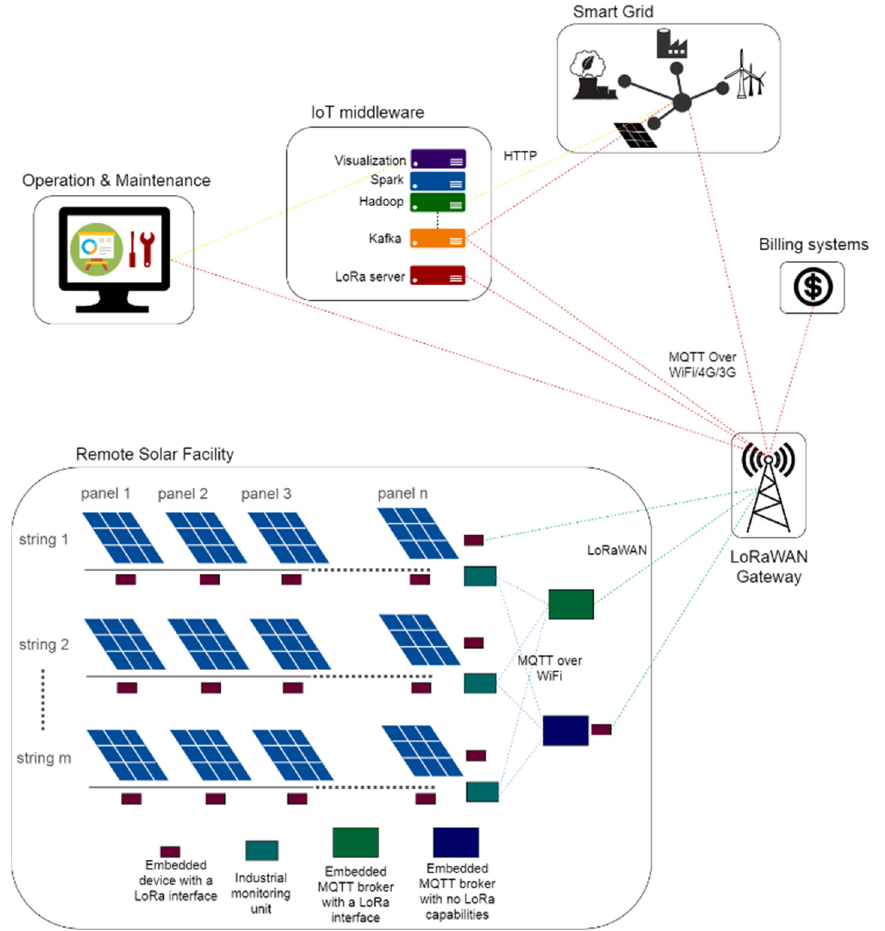
Figure 1. System Architecture.